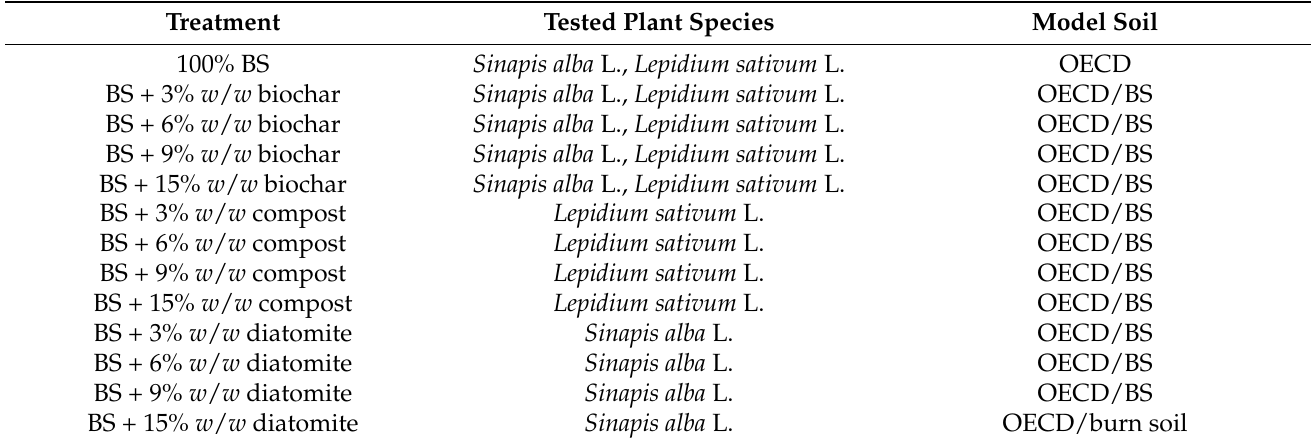
Table 1. Organization of phytotoxicity test. BS—burnt